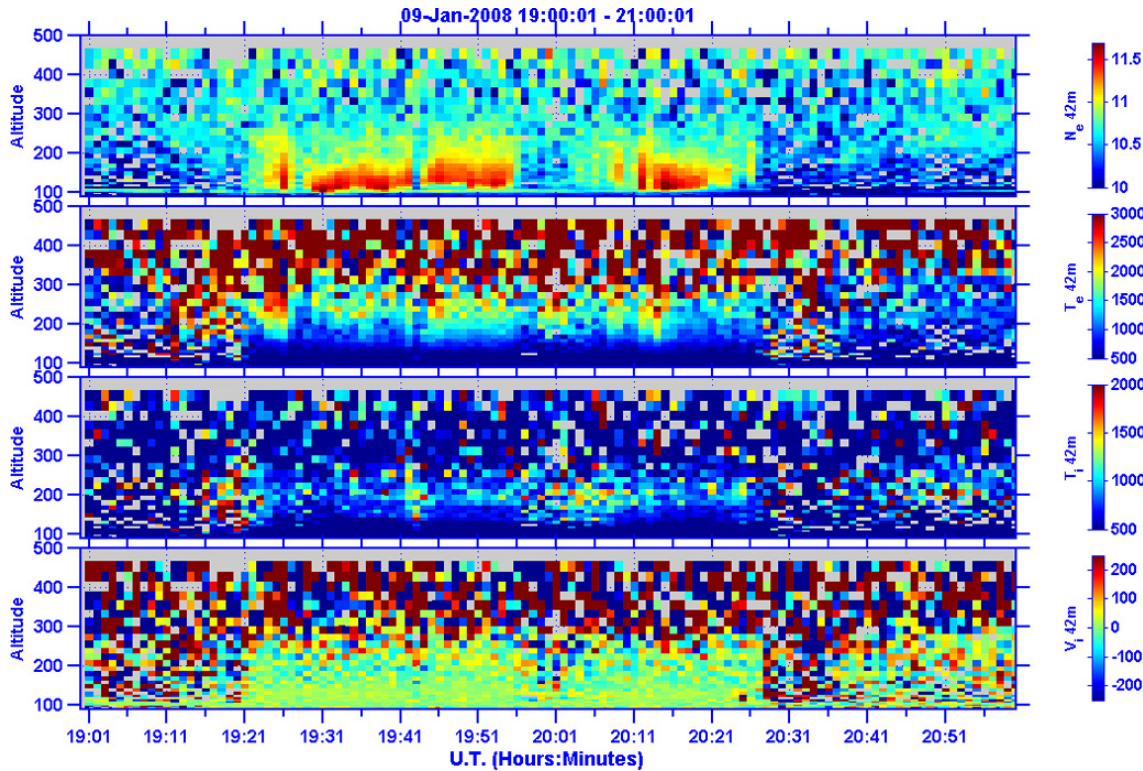
Fig. 9. ESR 42m dish – zenith observations. Upper panel represents N e (log ( N e ) with N e in m − 3 ), second T e (K), third T i (K), and fourth V i (ms − 1 ). Altitudes are in